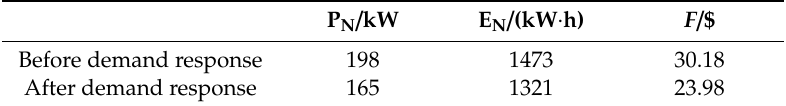
Table 1. Optimal power, capacity, and total cost before and after demand response.